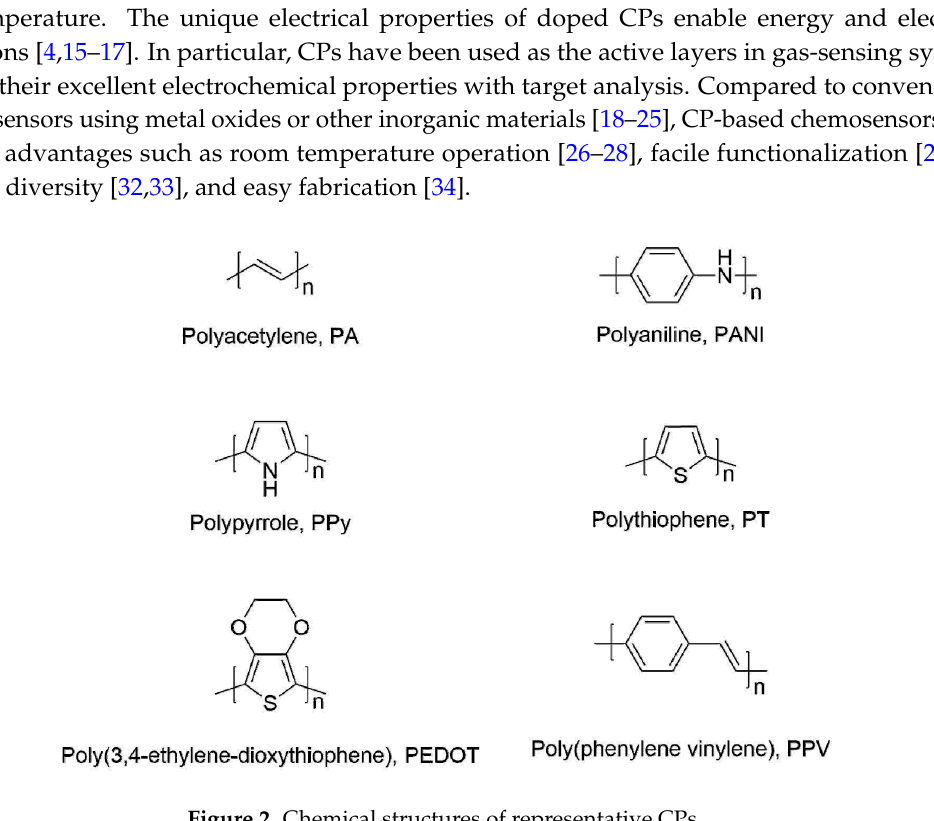
Figure 2. Chemical structures of representative CPs.